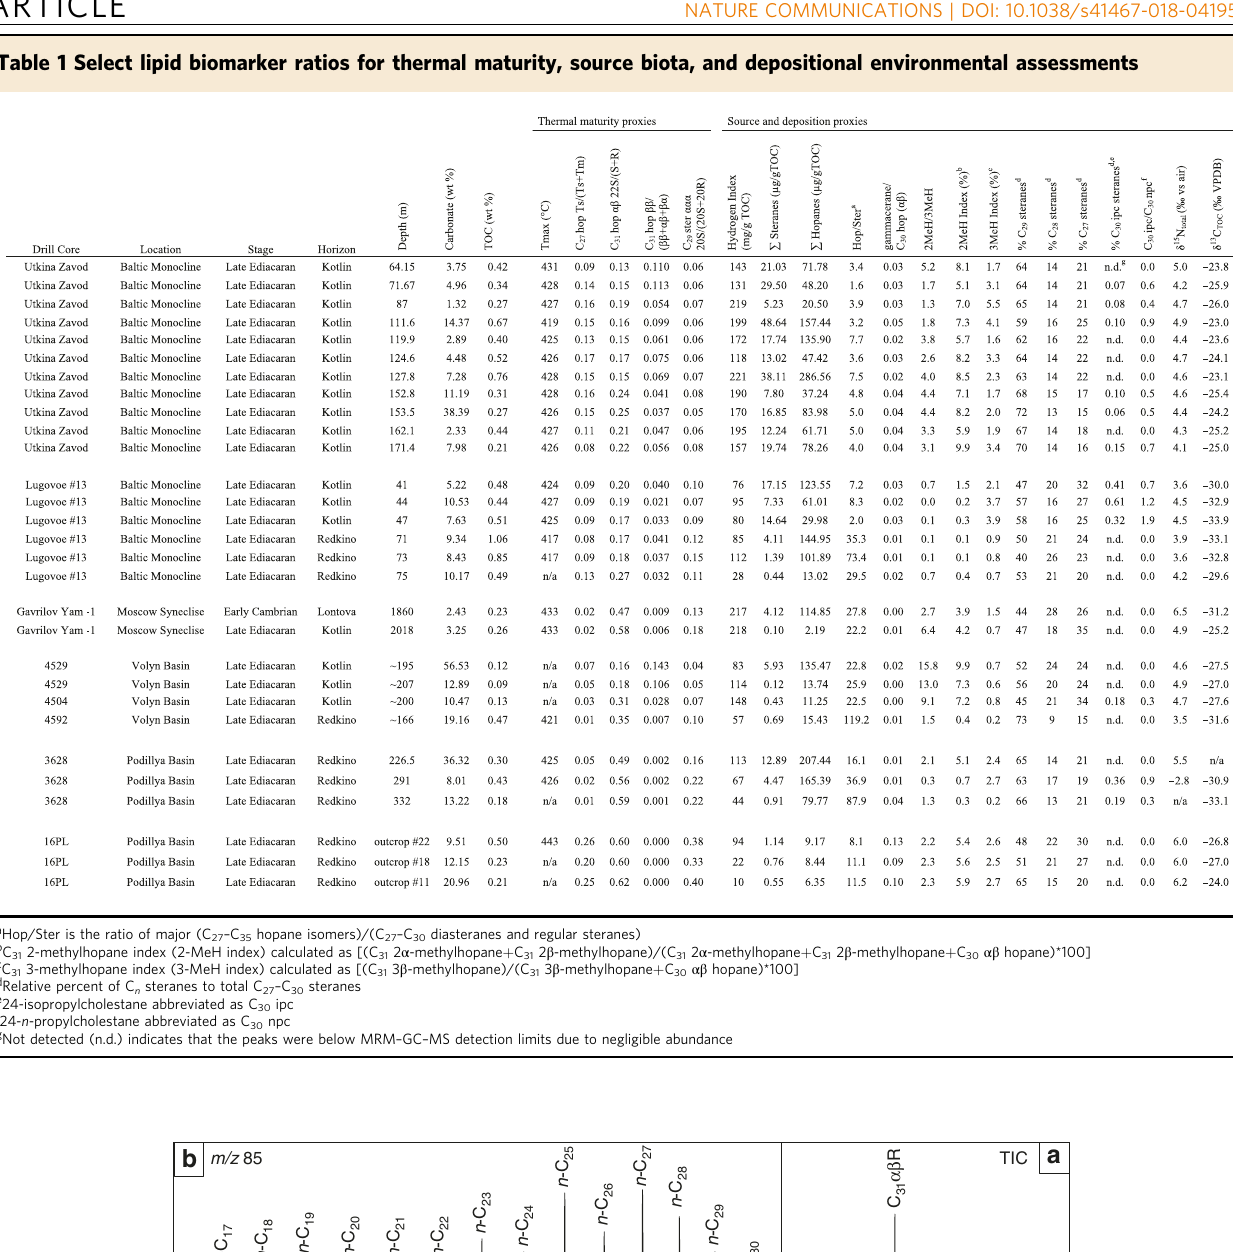
Table 1 Select lipid biomarker ratios for thermal maturity, source biota, and depositional environmental assessments